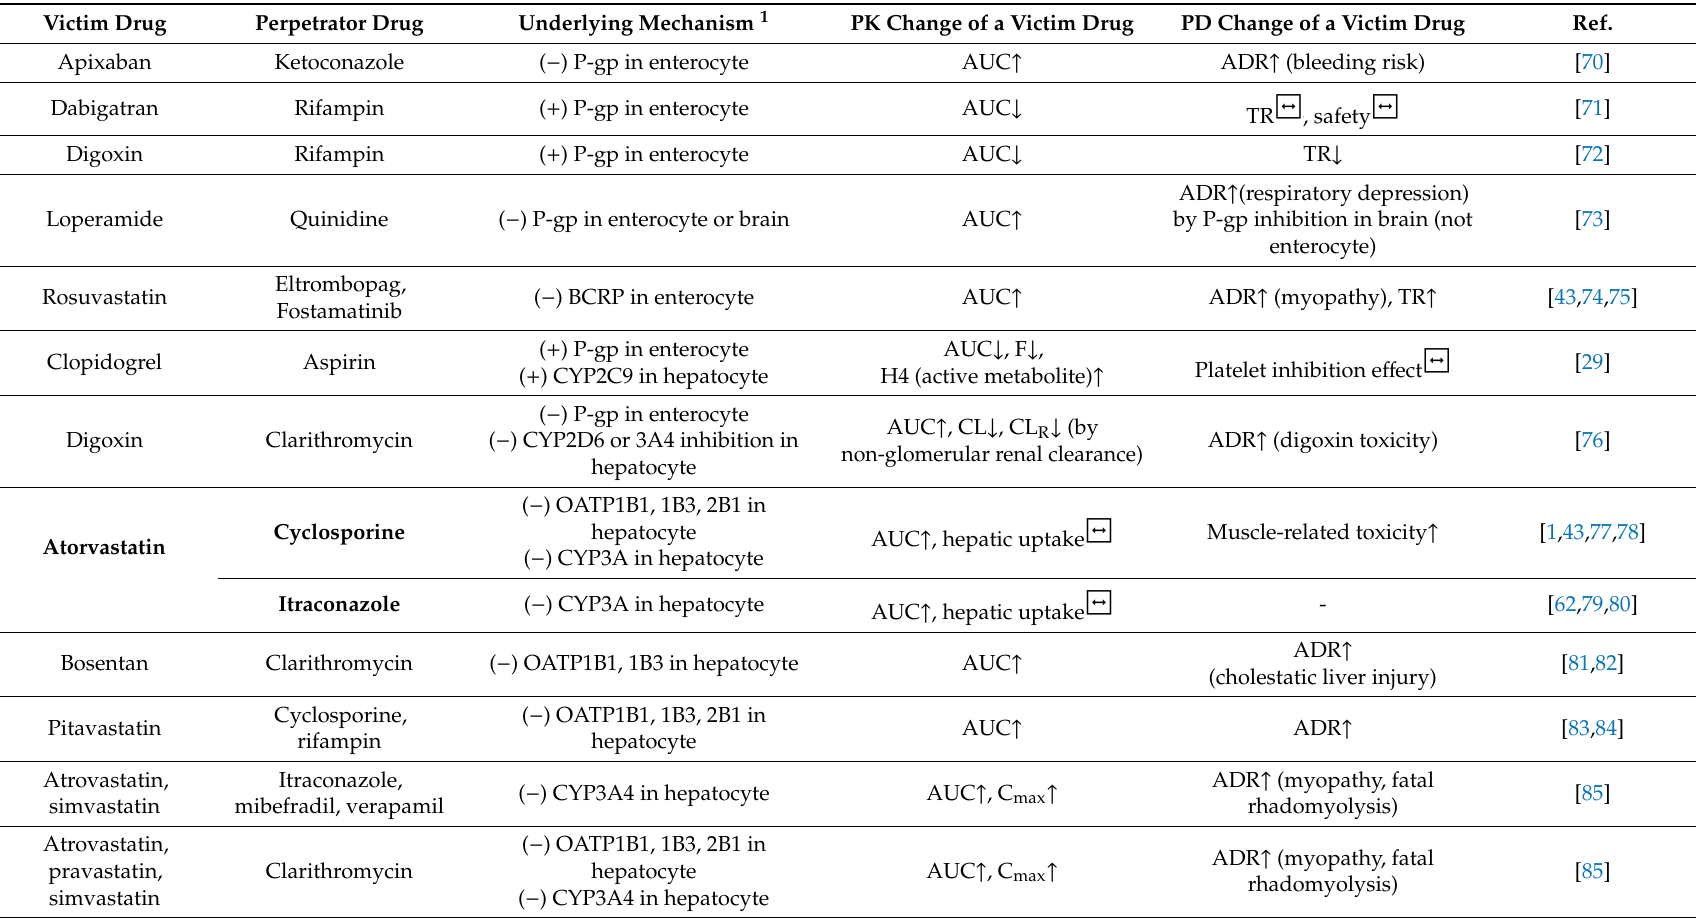
Table 2. Examples of transporter- or metabolic enzyme-mediated